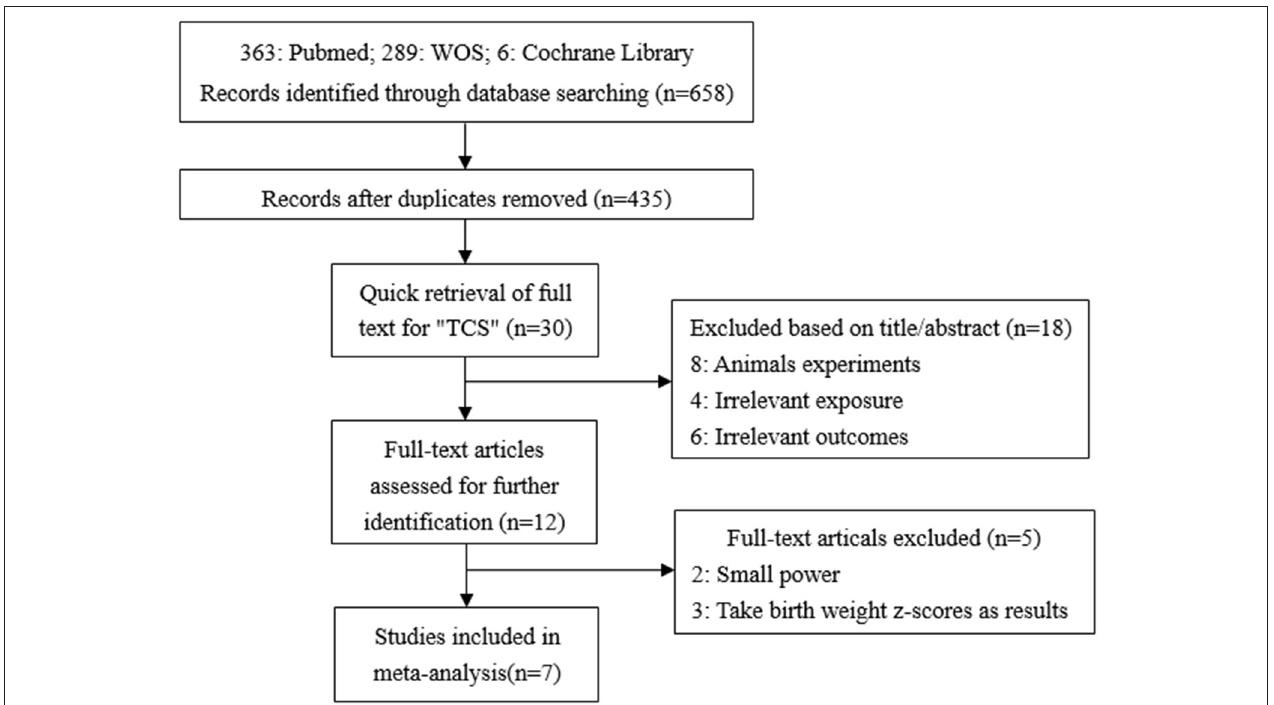
FIGURE 1 | Flow chart of the association between maternal urinary TCS level and neonatal birth weight.